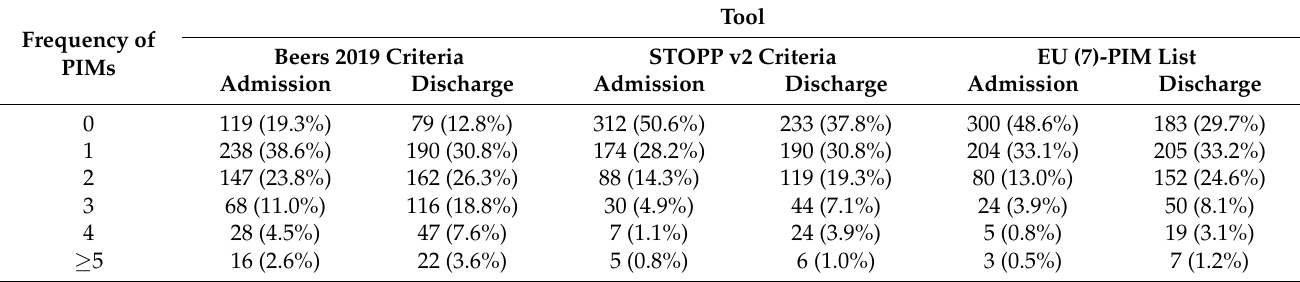
Table 2. Number of PIMs, according to the Beers and the STOPP criteria and the EU (7)-PIM list.